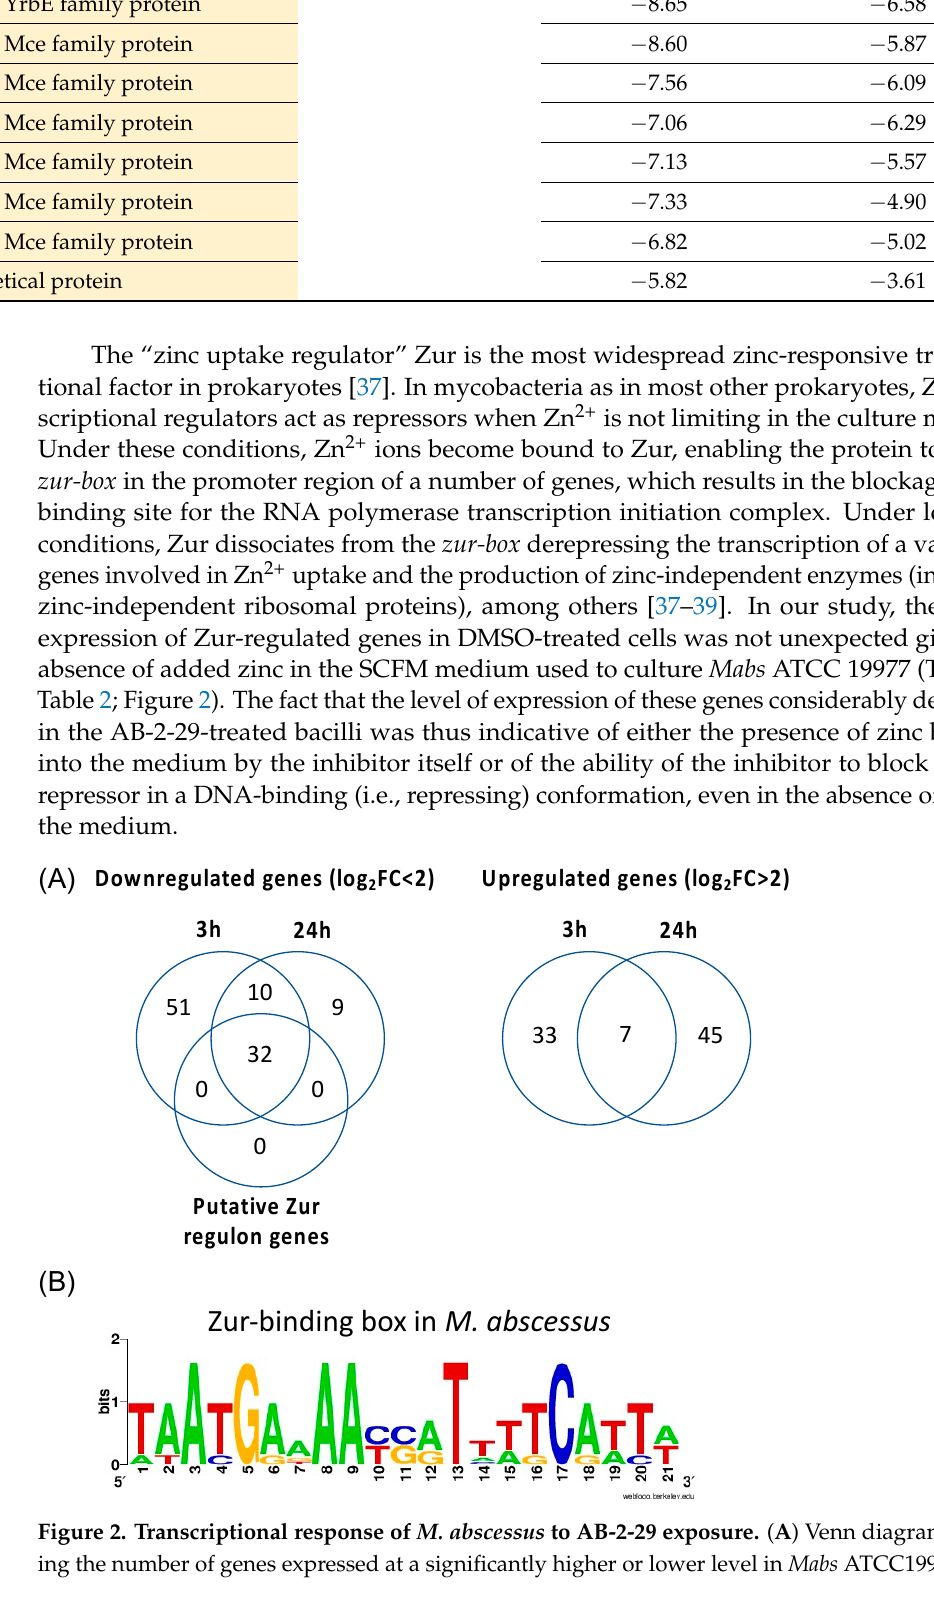
Figure 2. Transcriptional response of M. abscessus to AB-2-29 exposure. ( A ) Venn diagrams show- ing the number of genes expressed at a significantly higher or lower level in Mabs ATCC19977 upon exposure to 20 μ M AB-2-29 for 3 and 24 h compared to DMSO-treated bacilli, and the number of genes among these that are predicted to belong to the M. abscessus Zur regulon. The complete list of